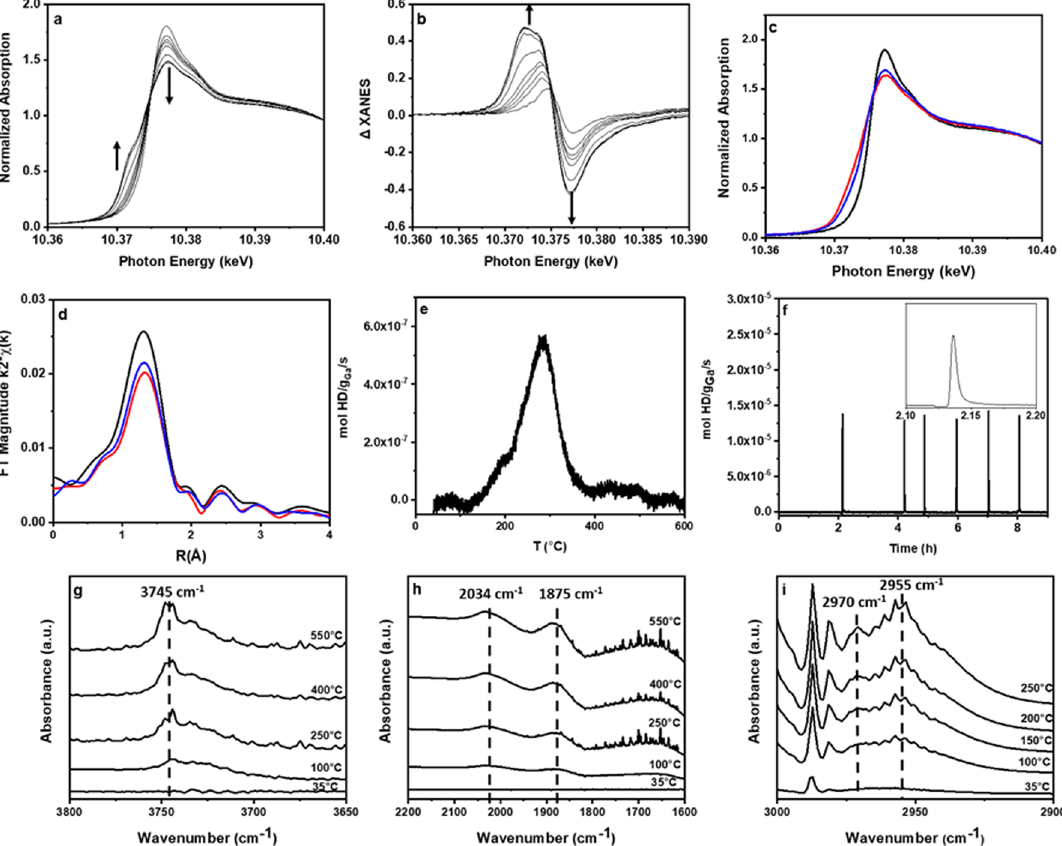
Fig. 3 Characterization of reaction intermediates on Ga/SiO 2 . a Normalized Ga K edge XANES at increasing temperature from 35 to 550 °C in pure H 2 . b The corresponding difference XANES. c Normalized Ga K edge XANES in C 2 H 4 at 550 °C (blue), H 2 at 550°C (red), and RT (black) sequentially. d The corresponding magnitude of the Fourier transform of the k 2 -weighted EXAFS. e The temperature of HD desorption from M – H/D 2 isotopic exchange by TPSR, f time on stream for gaseous HD formation. g The difference IR Si – OH spectrum from 3800 to 3650 cm − 1 after treatment in pure H 2 at increasing temperature from 35 to 550 °C. h The corresponding difference IR Ga – H spectrum from 2200 to 1600 cm − 1 . i The IR spectra in the C – H stretching region 2900 – 3000 cm − 1 after treatment in pure C 2 H 4 at increasing temperature from 35 to